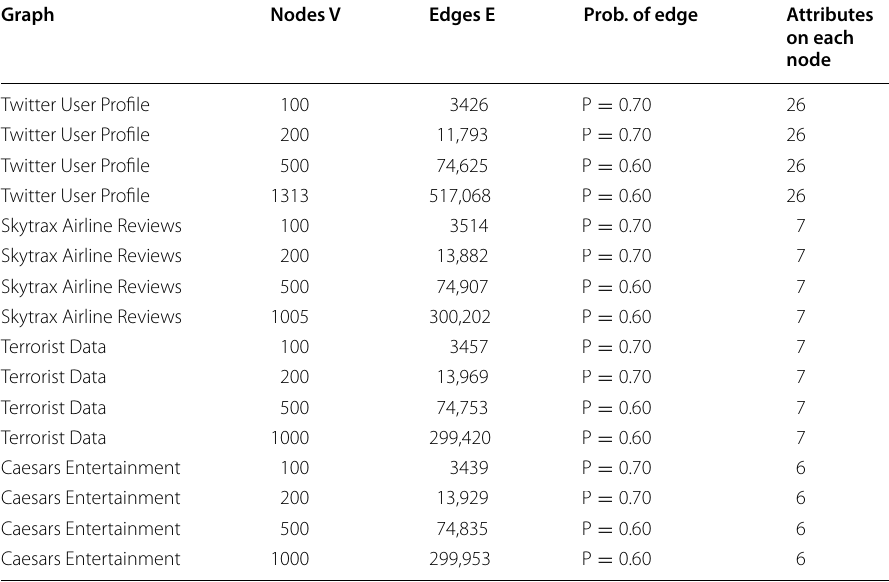
Table 7 Small graph datasets